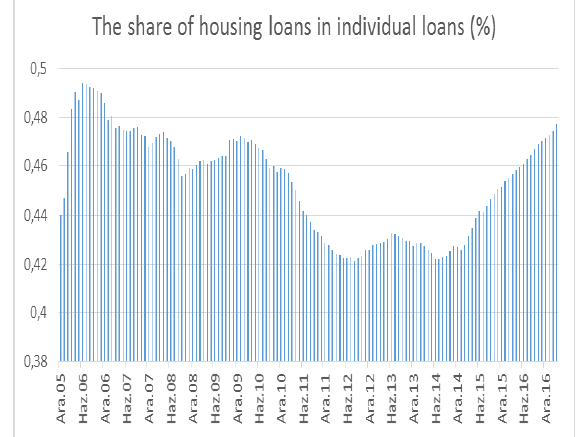
Figure 10. The Share of Housing Loans in Individual Loans (%) Source: TCMB, http://evds.tcmb.gov.tr/ Increase in the interest rates by CBTA affects the consumer confidence very sharply. It shows that there housing loans’ interest rate trend is downward.